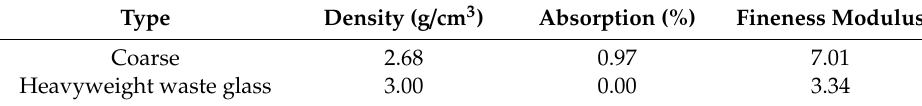
Table 2. Material properties of the aggregates.